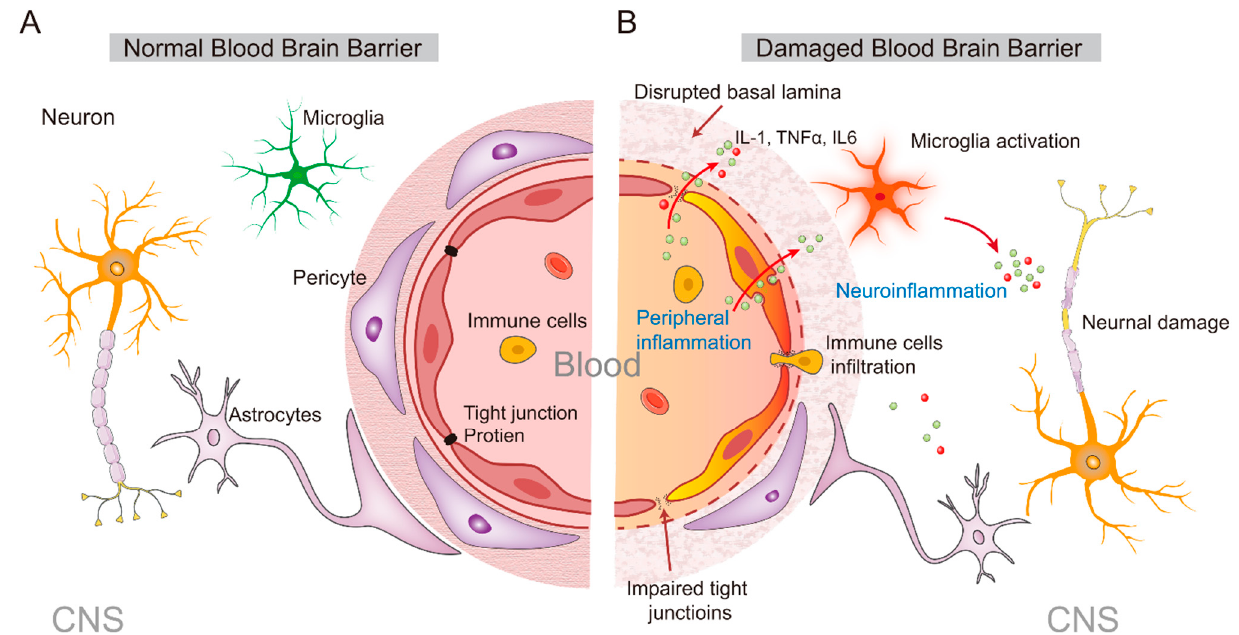
Figure 2. Increased periphery inflammation leads to disruption of the blood–brain barrier (BBB). ( A ) In healthy BBB, tight junctions between brain endothelial cells form the primary physical barrier that prevents the entry of large and potentially toxic molecules into the brain. Endothelial cells are encompassed by basal lamina, pericytes, and astrocytic endfeet. Pericytes and astrocytic endfeet interact closely with the endothelial cells and can help maintain BBB integrity. ( B ) Inflammation, caused by an infection or virus, can lead to immune cell infiltration. Increased periphery inflammation has a detrimental effect on the integrity of the BBB at various levels, including endothelial cell degradation or shrinkage, altered paracellular transport pathways via loss of tight junction proteins, as well as dysfunction of pericytes and astrocytes. Loss of BBB integrity makes it more permeable, allowing immune cells and inflammatory cytokines to enter the brain parenchyma, which in turn leads to microglial activation to induce neuroinflammation. Neurons may experience demyelination or become damaged.